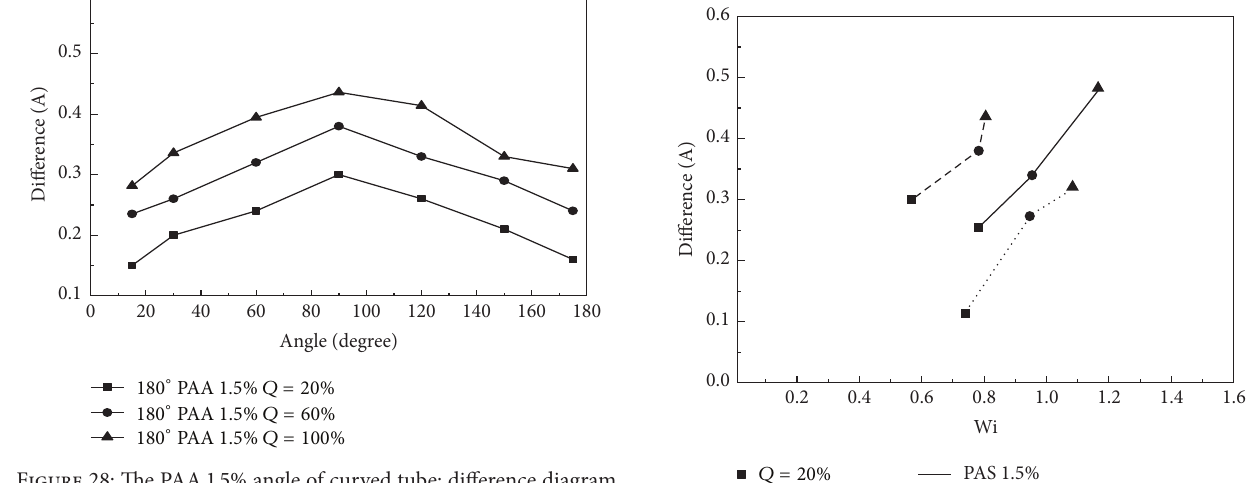
Figure 28: The PAA 1.5% angle of curved tube: difference diagram of various flows in 180 ∘ curved tube.